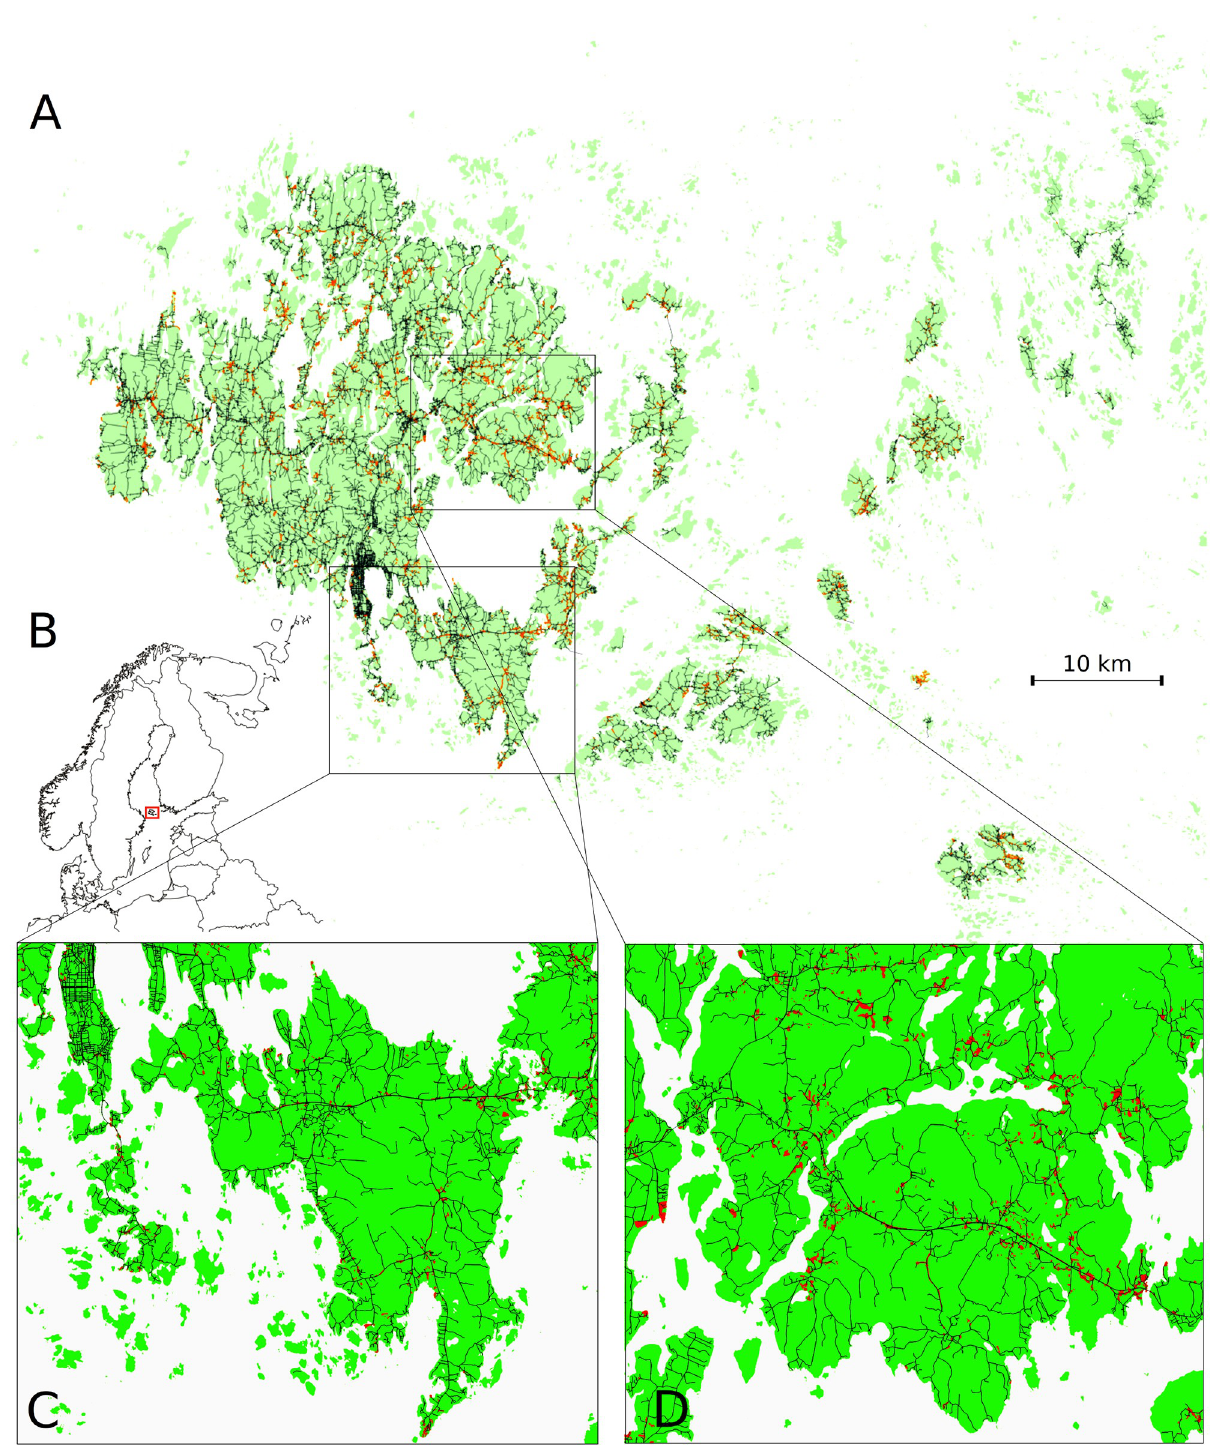
Fig 2. The study system consists of 3448 host populations situated in the main island of Å land island archipelago (panel A), that resides between Sweden and Finland in the Baltic sea (B). In panels A and C&D, the road network is shown in black and the host populations in red. The road network covers the main islands densely, and ferries operate between the islands. Panels C and D illustrate that typically host populations reside directly at a roadside, or in the close proximity to it. The map in panel B was produced using Geodata from European Commission, EuroGeographics for the administrative boundaries, while the other maps were produced with data produced by National Land Survey of